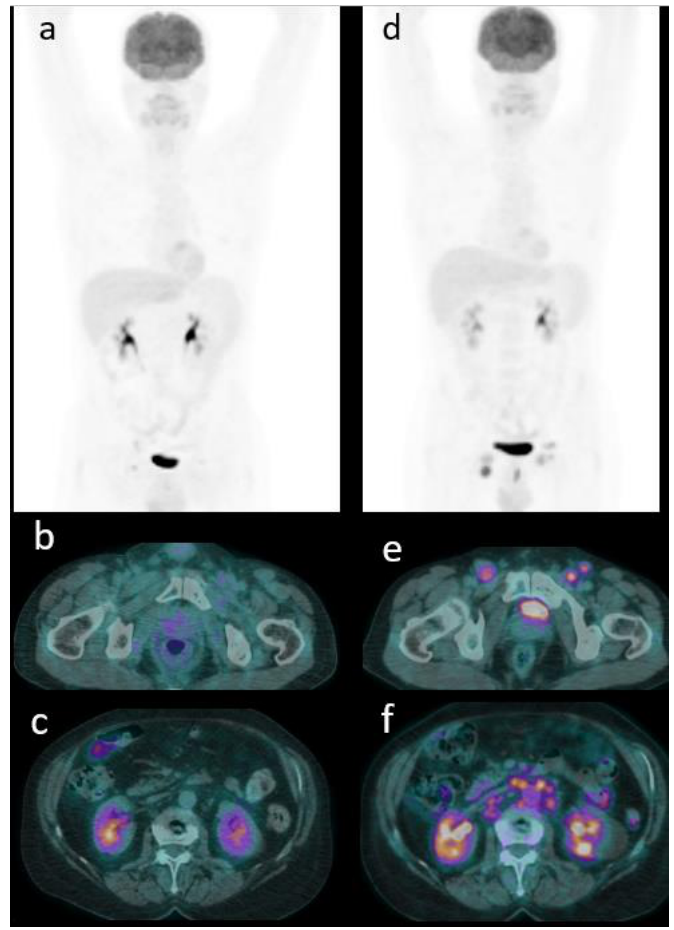
Figure 3. Restaging 18 F-FDG PET/CT ( a ) in a patient with moderate FDG uptake corresponding to right inguinal nodes ( b , c ). A follow-up PET/CT ( d ) demonstrating the metabolic progression of disease to the inguinal ( e ) and abdominal nodes ( f ).